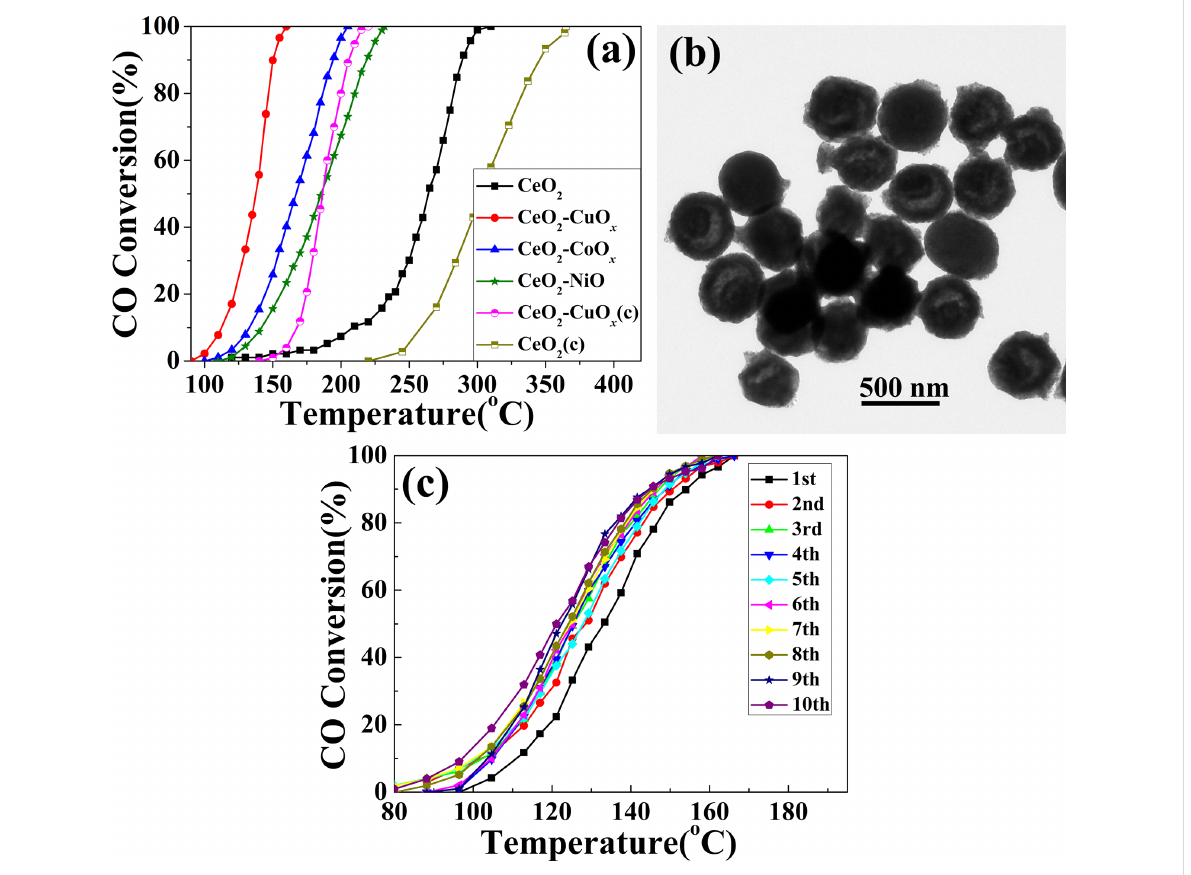
Figure 9: (a) CO conversions as a function of temperature for CeO 2 and CeO 2 –MO x composite yolk–shell nanospheres, and naked and CuO x -deco- rated commercial CeO 2 particles (denoted as CeO 2 (c) and CeO 2 − CuO x (c), respectively), WHSV = 60000 mL g -1 h -1 ; (b) TEM image of the CeO 2 –CuO x composite yolk–shell nanospheres after catalytic test; and (c) cycling test of the CeO 2 –CuO x composite yolk–shell nanospheres for CO